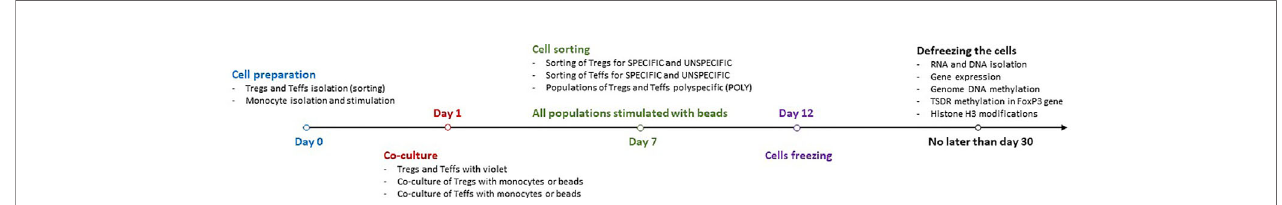
FIGURE 2 | The scheme of obtaining cells and their further